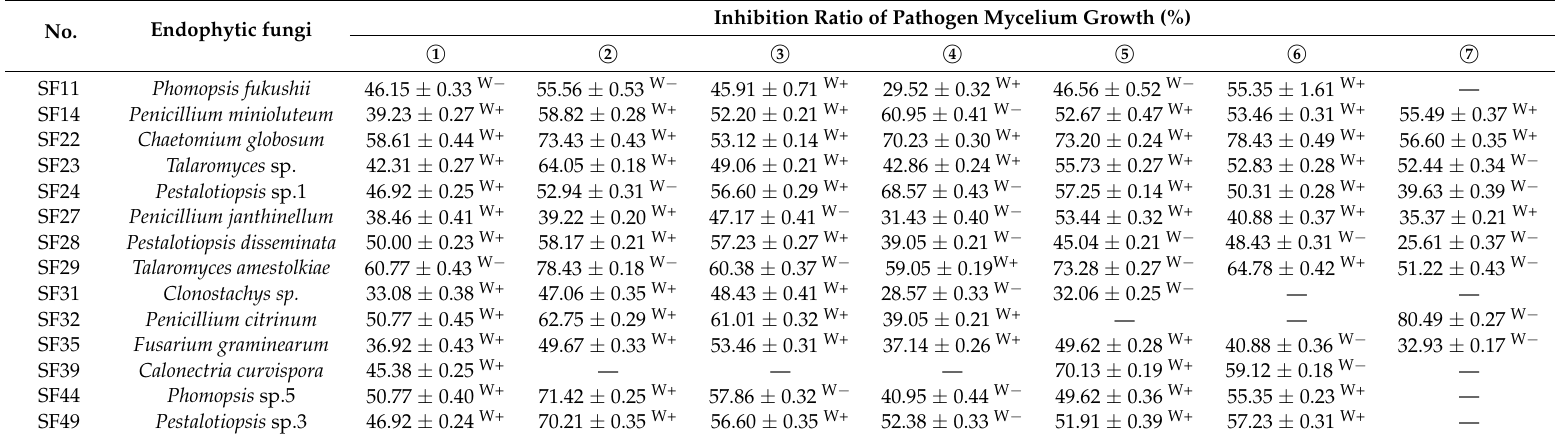
Note: Data presented are the means ± SD ( n = 3). 1 (cid:13) Colletotrichum gloeosporioides (Penz.) Penz. & Sacc.; 2 (cid:13) Phytophthora capsici Leonian; 3 (cid:13) Fusarium andiyazi Marasas, Rheeder, Lampr., K.A. Zeller & J.F. Leslie; 4 (cid:13) Alternaria alternata (Fr.) Keissl.; 5 (cid:13) Phomopsis sp.; 6 (cid:13) Ceratosphaeria phyllostachydis Zhang; 7 (cid:13) Rhizoctonia solani Kühn; − : No inhibition zone; + : Inhibition zone; w: Pathogen hyphae shrink; –: No